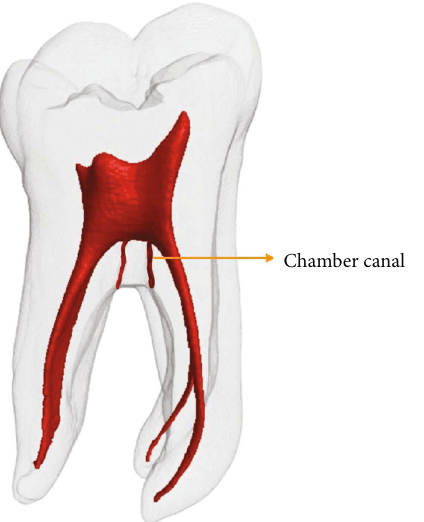
Figure 1: Schematic representation showing chamber canals.